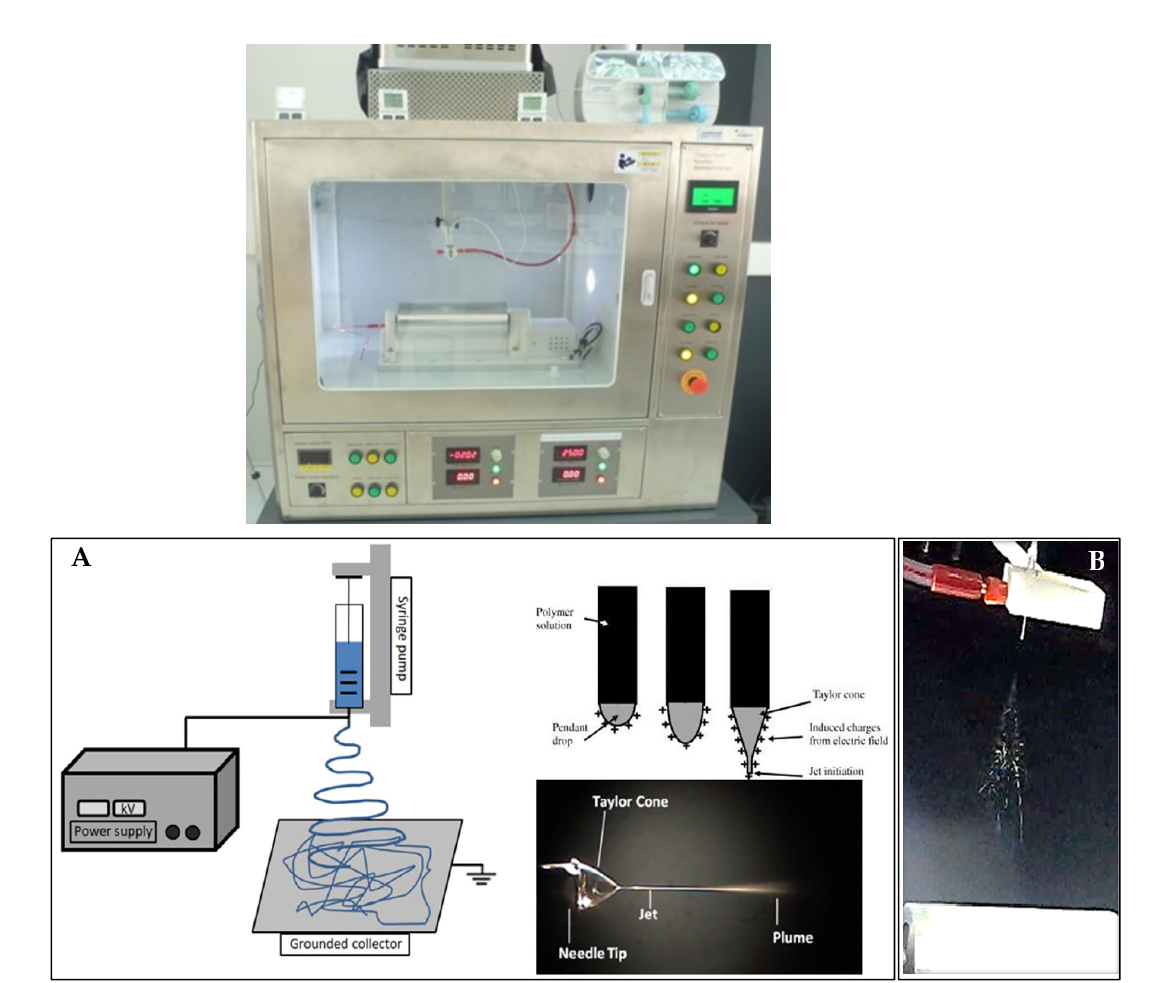
Figure 1. ( A ) Schematic representation of an electrospinning apparatus, showing the formation of the Taylor’s cone. Figure from Luraghi et al. [46] with permission from Elsevier. ( B ) Electrospun fiber formation.